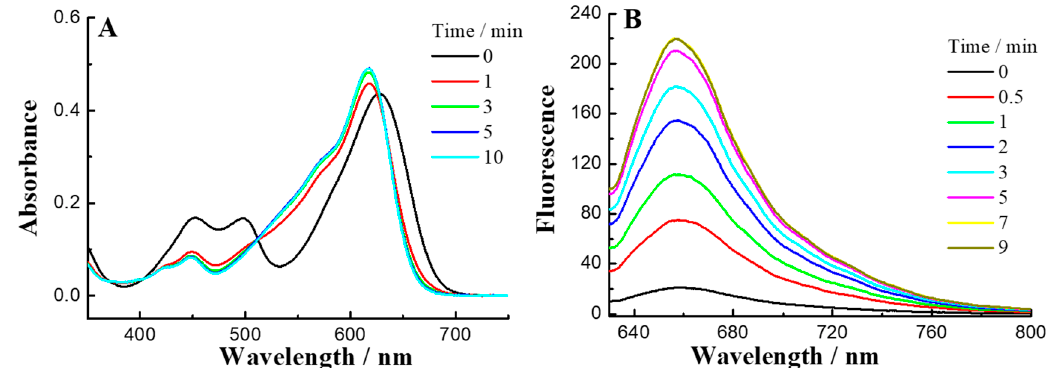
Figure 1 . ( A ) Time-dependent absorbance spectra of 1 (5 µM) and H 2 S (500 µM) in PBS (50 mM, pH 7.4, containing 10% DMSO). ( B ) Time-dependent fluorescence spectra (excitation = 620 nm) of 1 (2 µM) and H 2 S (200 µM).